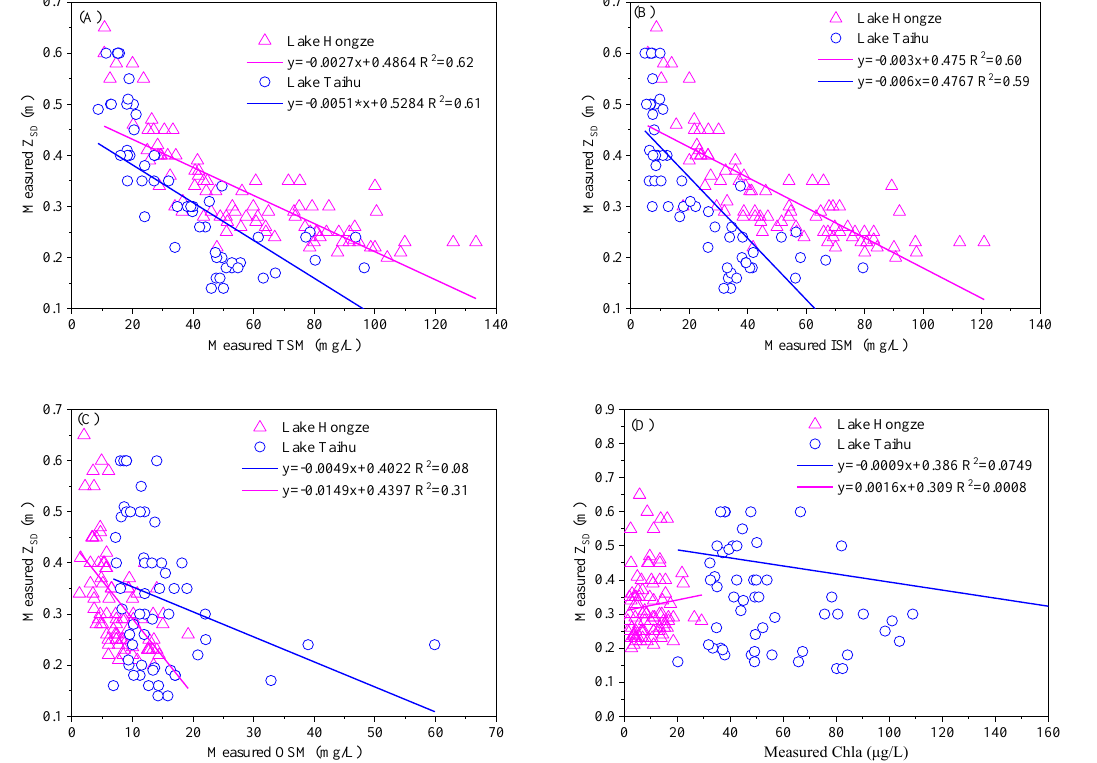
Figure 7. The relationship between measured Z SD and measured water quality parameters in Lake Hongze and Taihu: ( A ) total suspended matter (TSM), ( B ) inorganic suspended matter (ISM), ( C ) organic suspended matter (OSM), and ( D ) Chla.